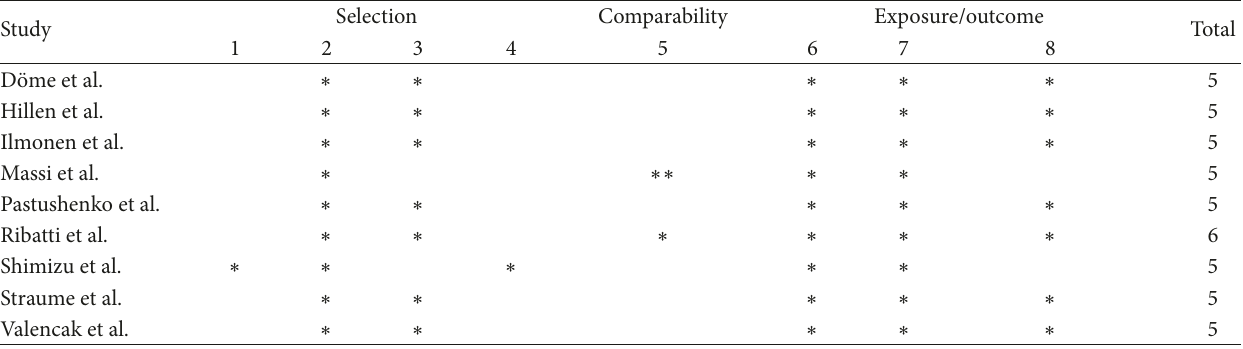
Table 6: Newcastle-Ottawa Scale.